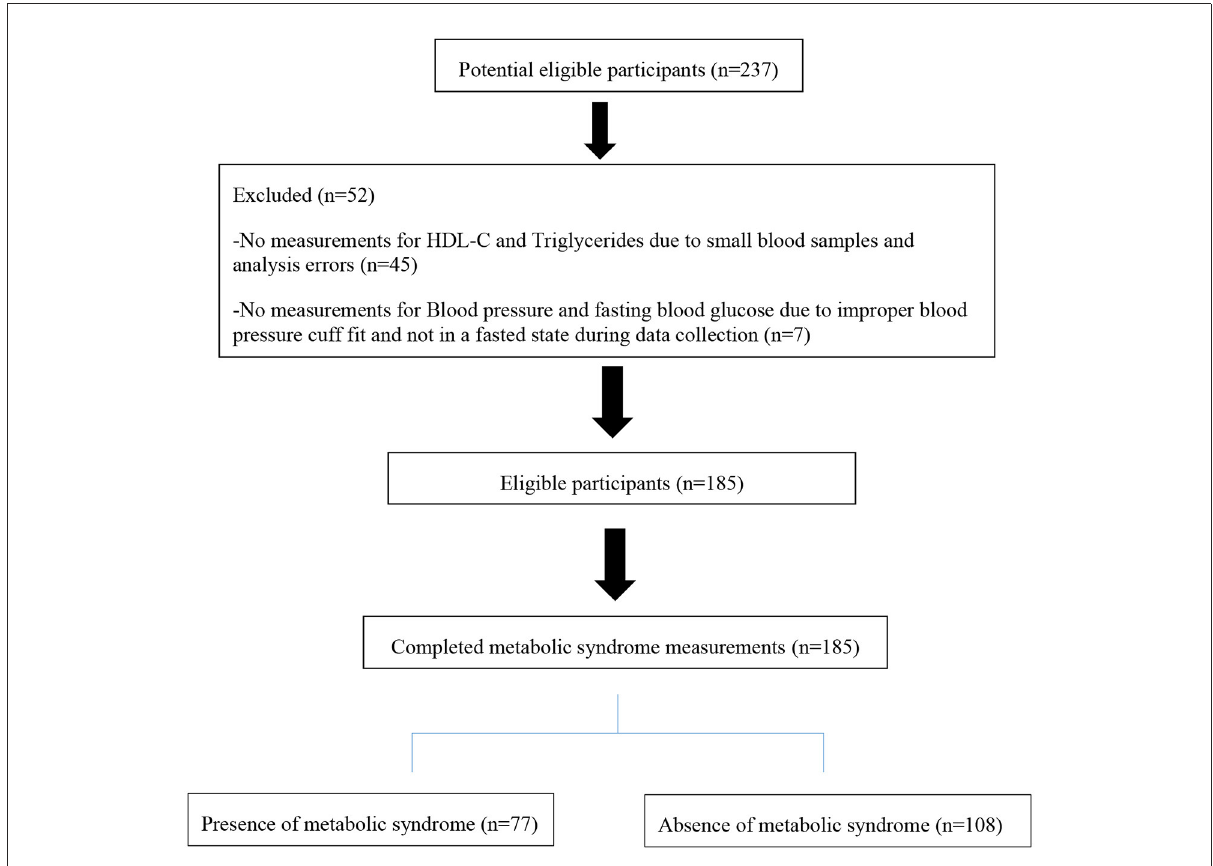
FIGURE1 Flow diagram of participants’ selection for this